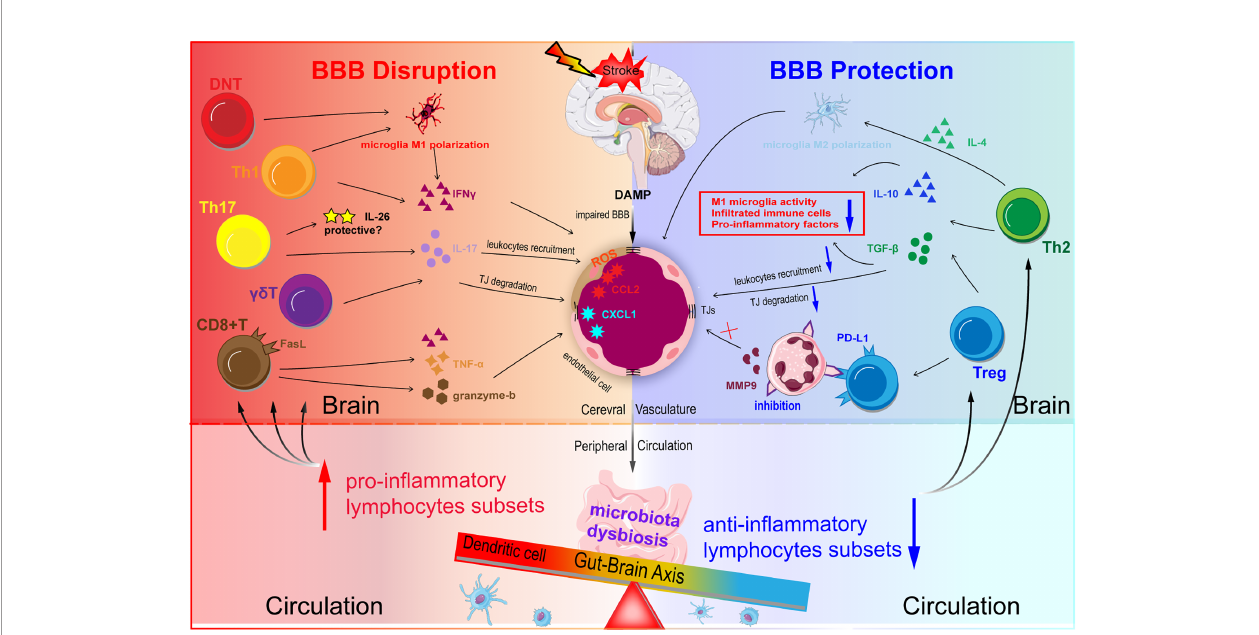
FIGURE 3 | Schematic representation of T lymphocytes homeostasis disorder regulating BBB integrity in ischemic stroke. DAMP and chemokines are released from the ischemic brain via impaired BBB. Acute infarction in the brain can induce microbiota dysbiosis in the gut. Microbiota dysbiosis abolishes the ability of Dendritic cells (DC) to drive the Treg differentiation and promotes the power of DC to induce gd T cell differentiation. The disturbed balance between pro-in fl ammatory subsets and anti-in fl ammatory subsets contributes to BBB disruption during ischemic stroke. Th1 and Th17 may degrade TJs and destroy BBB integrity through secreting IFN- g , IL-17, and IL-21 in the acute phase. CD8 + T cells potentiate the ischemic stroke progression by two main methods: one is granzyme-b and FasL induced cytotoxicity through FasL-PDPK1 pathway and the other is TNF- a and IFN- g . Treg suppresses the overactivation of resident microglia, in fi ltrated T cells, and neutrophils, and decrease pro-in fl ammatory factors (TNF- a , IFN- g , IL-1 b ) levels mainly through the action of IL-10 and TGF- b